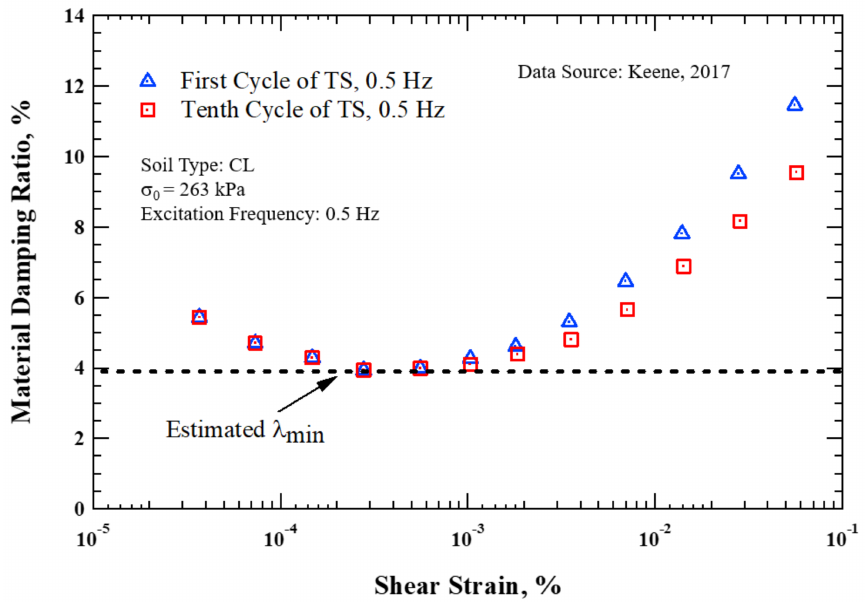
Figure 3. Material damping analyzed by stacking only method